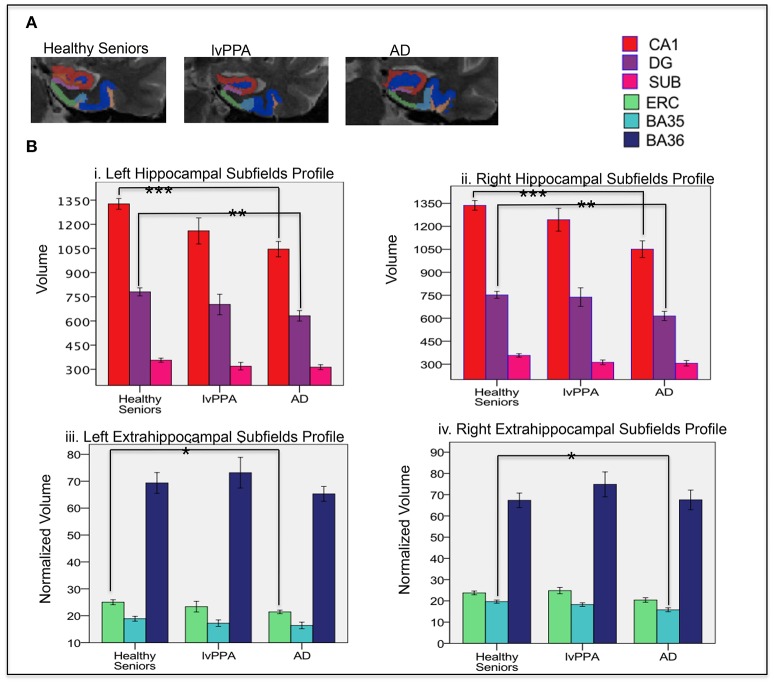
(A) A representative segmentation of left MTL subfields in one of the participants in each group (healthy senior, lvPPA, AD) shown in a coronal view. (B) Profile of volume of left and right hippocampal and extrahippocampal subfields across cohorts. *p < 0.05, **p < 0.005, ***p < 0.001. CA, Cornu Ammonis; DG, dentate gyrus; SUB, subiculum; ERC, entorhinal. and perirhinal cortices (BA35 and BA36).